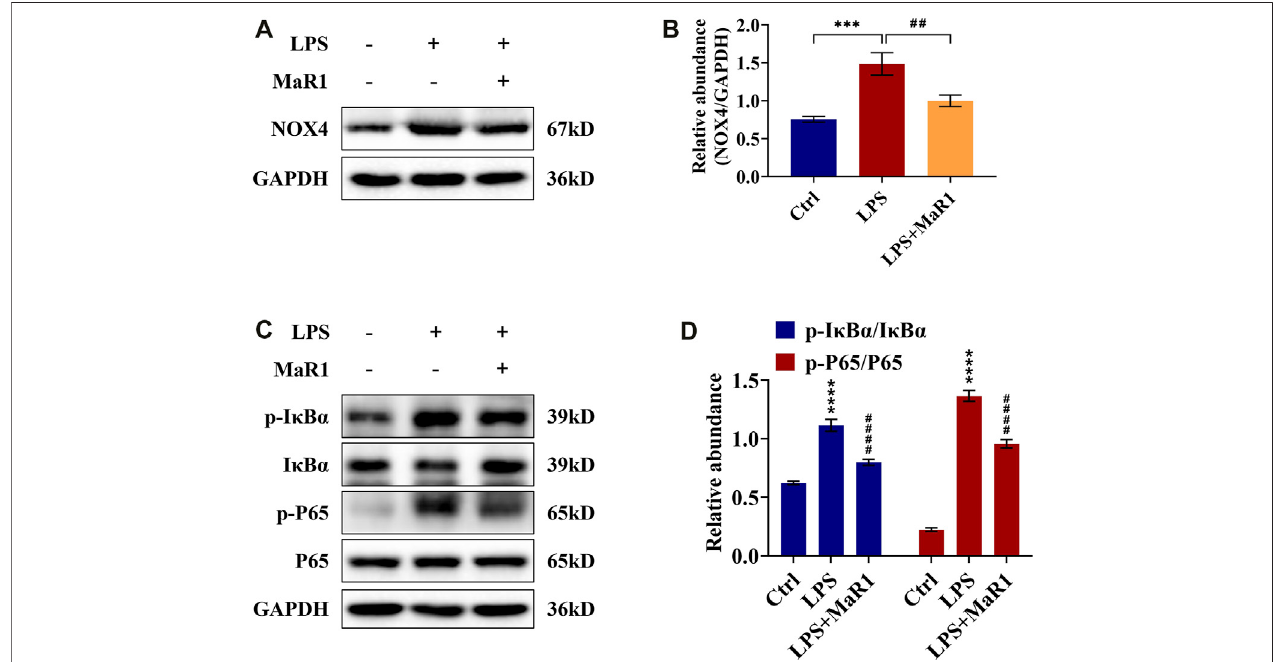
FIGURE7| MaR1suppressedNOX4expressionandNF- κ Bpathwayactivationoflipopolysaccharide(LPS)-stimulatedTCMK-1cells. (A) TheexpressionofNOX4 in TCMK-1 cells was analyzed using Western blot. (B) The protein level of NOX4 in TCMK-1 cells was quanti fi ed by densitometry and normalized with GAPDH. (C) The expressionsofp-I κ B α ,I κ B α ,p-P65,andP65inTCMK-1cellswereanalyzedusingWesternblot. (D) Theproteinlevelsofp-I κ B α /I κ B α andp-P65/P65werequanti fi